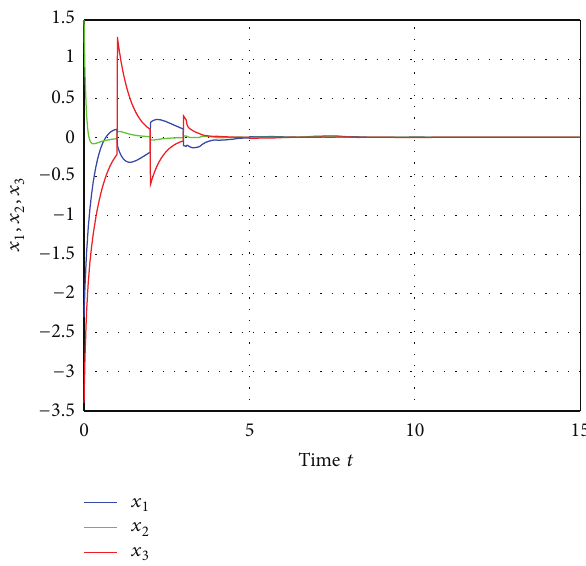
Figure 1: Simulation of exponential convergence of